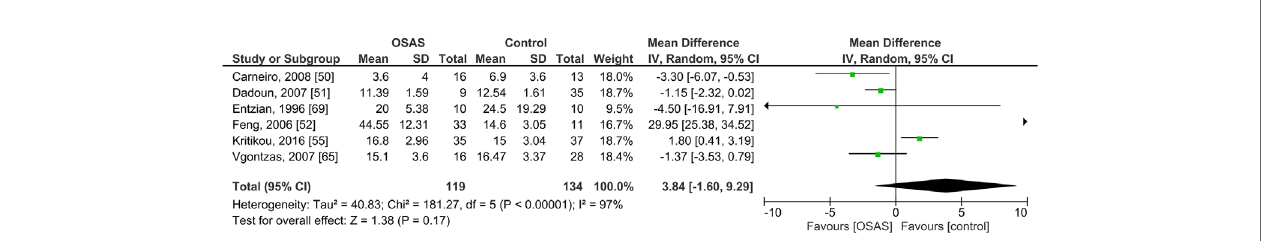
FIGURE 4 | Forest plot of random-effects analysis of plasma cortisol levels in adult obstructive sleep apnea syndrome (OSAS) versus the control group. The diamond shape indicates the pooled mean difference (MD). Each black box represents a point estimate of each study and also gives a representation of the study size (the bigger the box, the more participants in the study). A horizontal line representing the 95% con fi dence intervals (CIs) of the study result, with each end of the line representing the boundaries of CI. SD, Standard deviation.